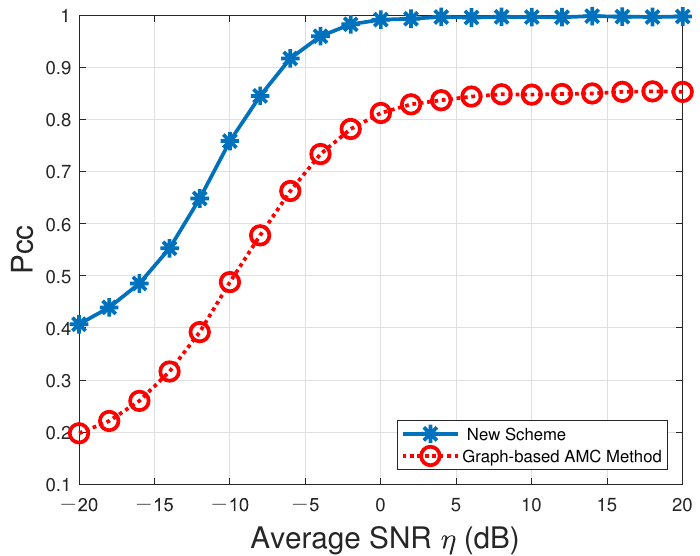
Figure 4. Probabilities of correct classification, P cc, versus average SNR for our proposed new VSDF CAMC approach and the existing single-node graph-based AMC method in [22] in the presence of multipath Rayleigh channels and AWGN over the modulation candidate set M def = { BPSK,OQPSK,QPSK,2FSK,4FSK,MSK }